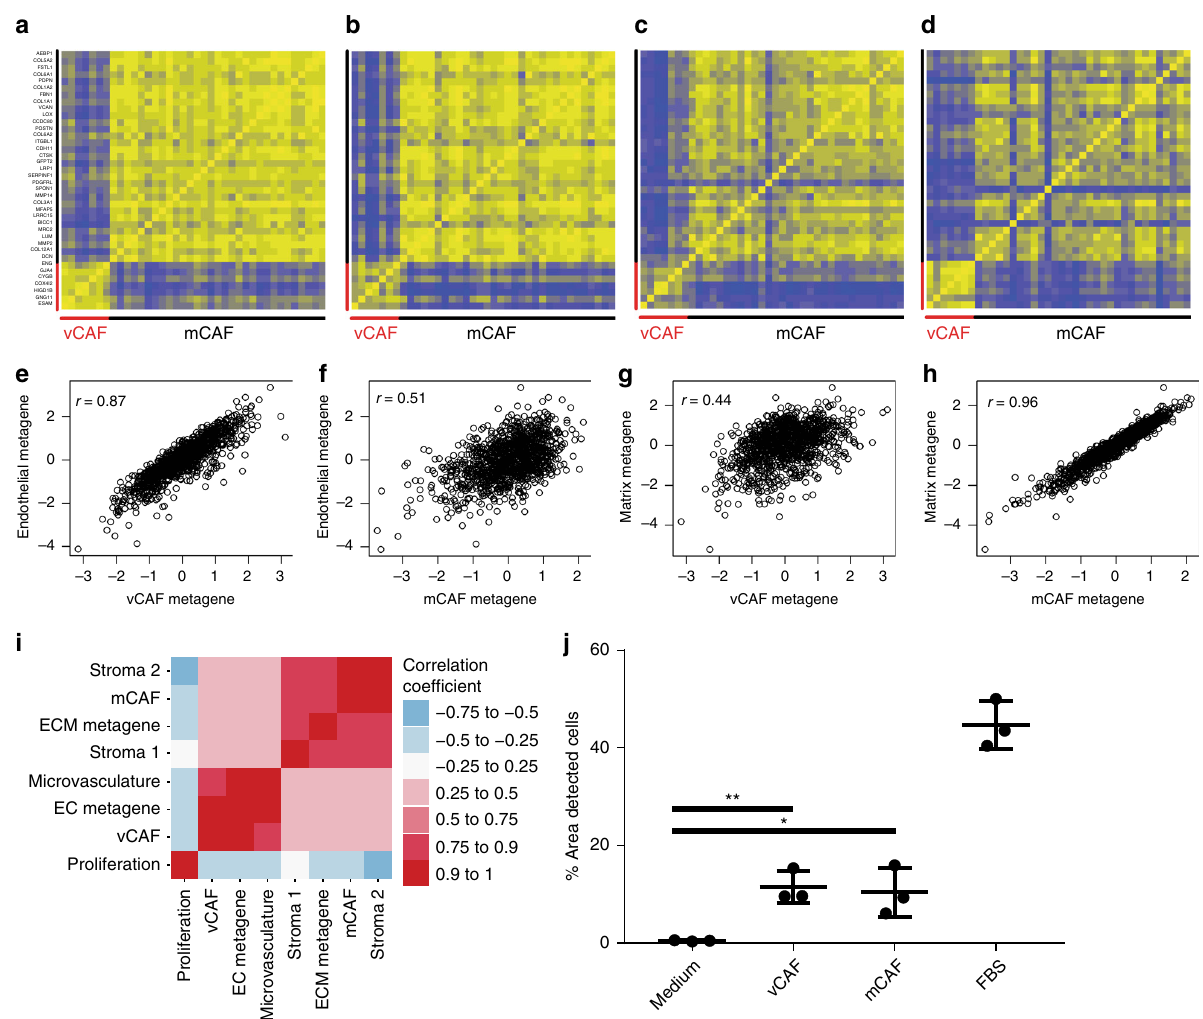
Fig. 5 CAF gene pro fi les correlate in human bulk RNA-sequencing data. Pearson correlation of genes from vCAF and mCAF pro fi les in TCGA datasets of a breast cancer, b pancreatic ductal adenocarcinoma, c lung adenocarcinoma, and d renal clear cell carcinoma. Correlation of the vCAF pro fi le to e an endothelial metagene and f a matrix metagene. Correlation of the mCAF pro fi le to g an endothelial metagene and h a matrix metagene in TCGA breast cancer data. i Correlation of vCAF and mCAF pro fi les to functional metagenes in the nested case – control study dataset of breast cancer patients. j Quanti fi cation of transwell invasion assay. The average percentage of area covered by invaded cells on the bottom of the membrane was quanti fi ed from 4 representative images in n = 3 biological repeats; Data depicted as mean ± s.d. * P = 0.026, ** P = 0.0045; two-sided, unpaired Students t